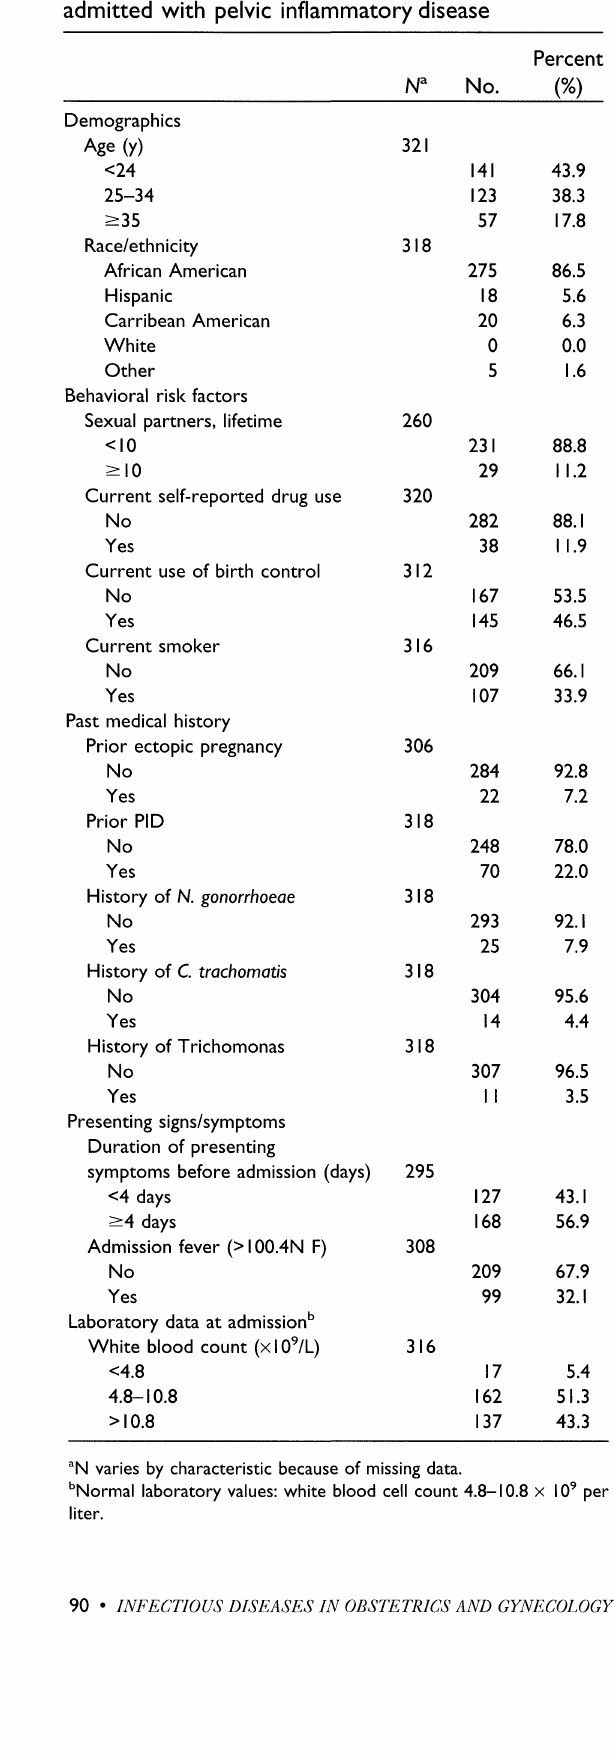
TABLE I. Characteristics of HIV-negative women admitted with pelvic inflammatory